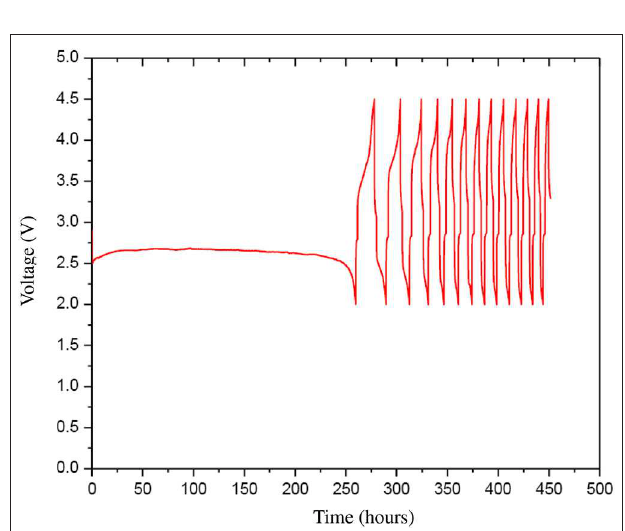
FIGURE 9 | The discharge-charge cycles (13 cycles) with 0.1mA current of the refined optimized Li-air battery cell that was prepared from the refined optimized cathode, HBP electrolyte, and anode